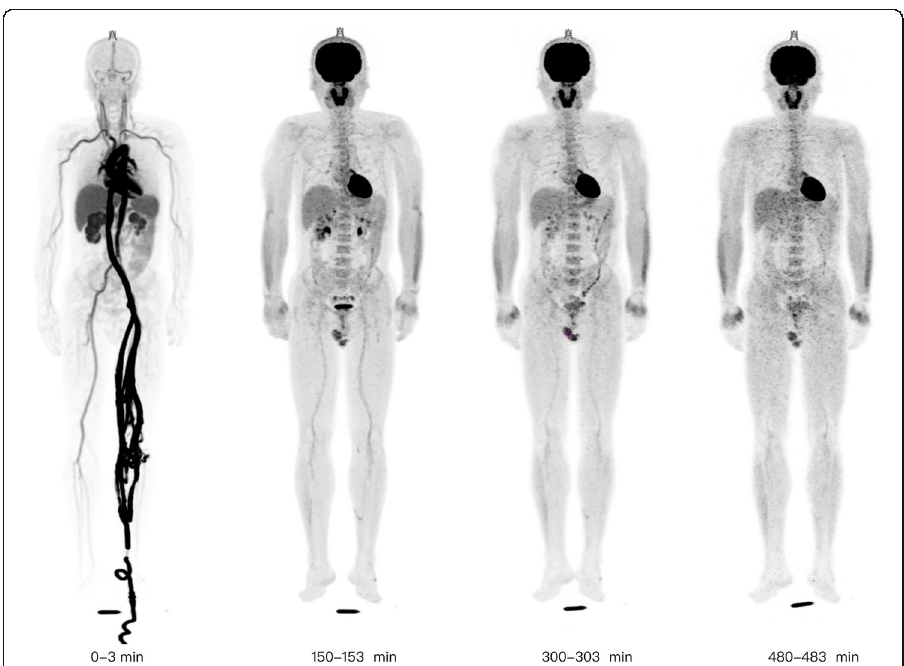
Fig. 1 Reconstructed dynamic PET images (Maximum-Intensity Projection) of early 3 min, 150~153 min, 300~303 min, 480~483 min (with calibration source close to the